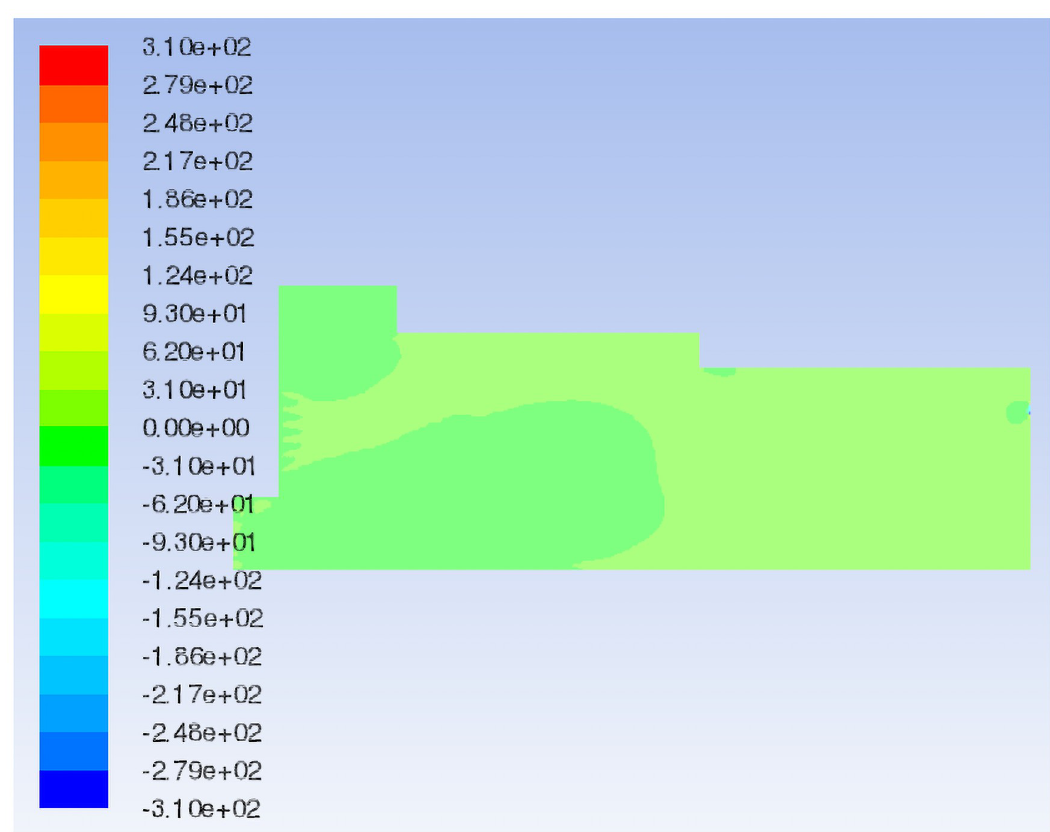
Fig 9. Flow field total pressure distribution of the original model.